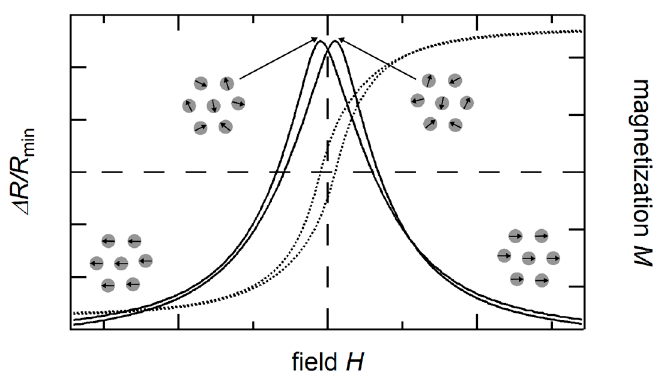
Figure 3. Schematic illustration of the granular GMR (solid line) in dependence of the applied field and sample magnetization (dotted line). The granular GMR exhibits the highest resistance at the coercive field as the magnetic moments of the particles are randomly oriented there. The dashed lines are a guide to the eye.